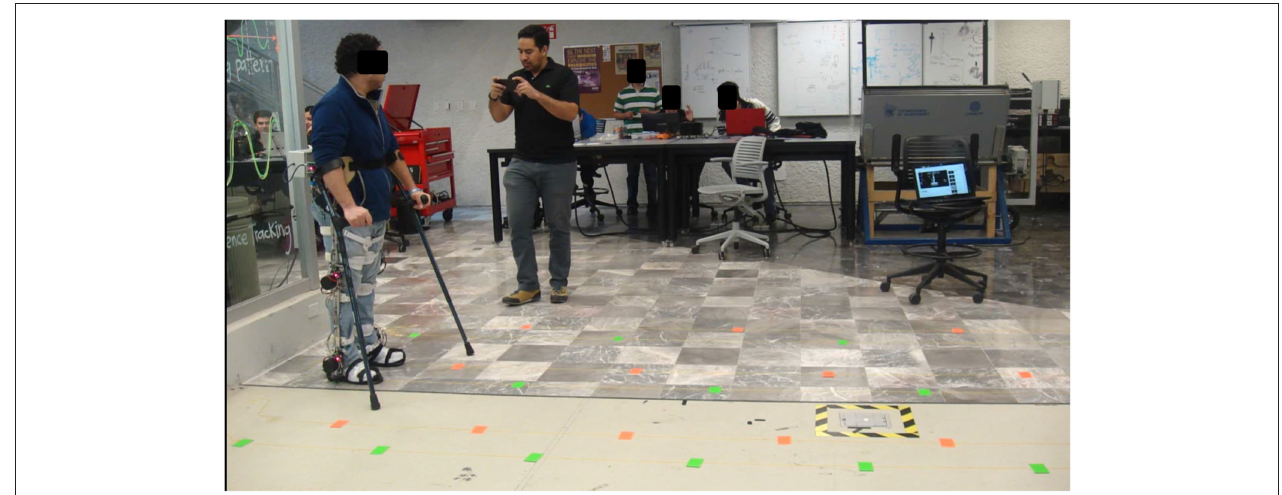
FIGURE 1 | Experiment setup. The healthy subject is donning the exoskeleton and using crutches in order to replicate the case of use in rehabilitation. At the bottom there are colored marks on the floor making three lanes, one for each of three step lengths. Green marks are for the right foot and orange for the left one. The setup does not have to be modified during experimentation, as the marks in each lane are fixed.